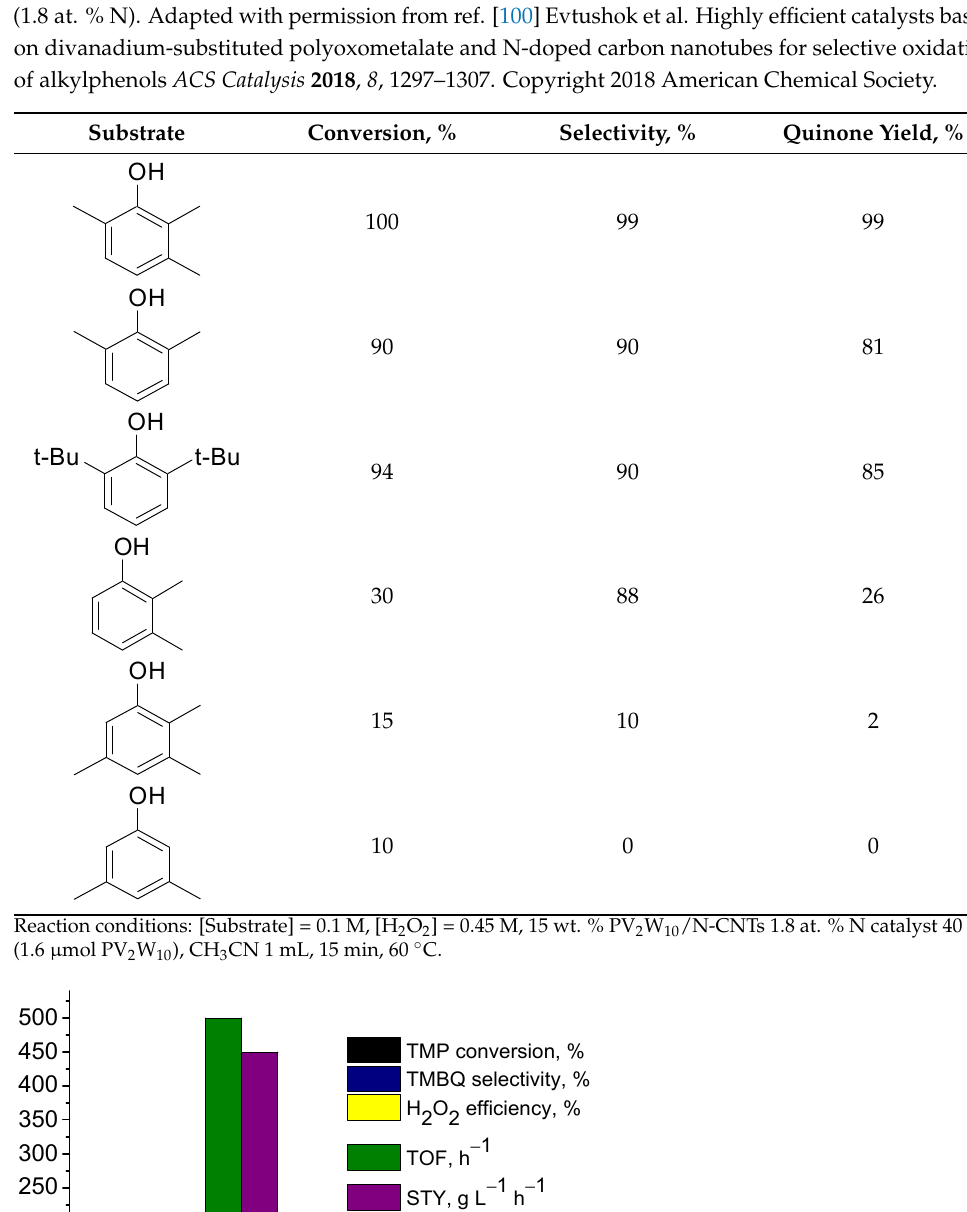
Figure 11. Catalytic characteristics of PV 2 W 10 /N-CNTs in TMP oxidation to TMBQ with H 2 O 2 . (STY: space-time yield). Adapted with permission from ref. [100] Evtushok et al. Highly efficient catalysts based on divanadium-substituted polyoxometalate and N-doped carbon nanotubes for selective oxidation of alkylphenols ACS Catalysis 2018 , 8 , 1297–1307. Copyright 2018 American Chemical Society.